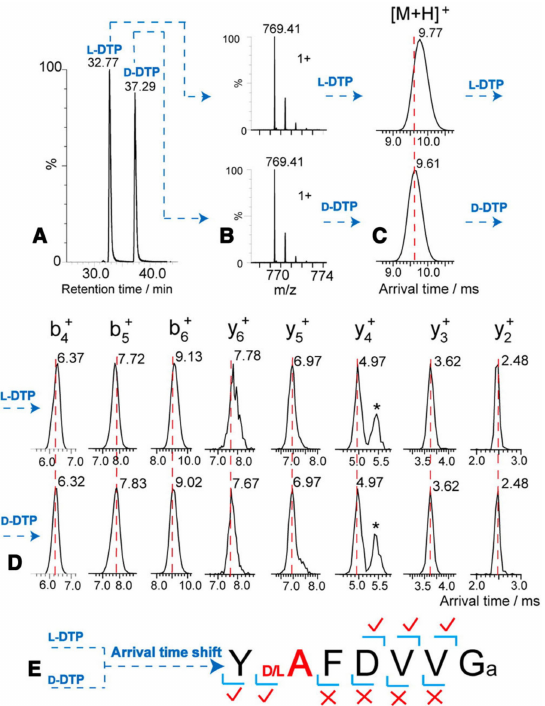
Figure 3. Identification of the epimerization site with LC–MS IMS by comparing the arrival times of the ions of deltorphin having L-Ala (labeled L-DTP) or D-Ala (labeled D-DTP). ( A , B ) LC–MS separation shows similar MS profiles and different retention times, indicating that they are isomeric peptides. ( C ) A shift in arrival time is detected for the L/D-forms. ( D , E ) Following IMS fragmentation, the arrival times of y 2+ , y 3+ , y 4+ and y 5+ are similar in both L-DTP and D-DTP, while the arrival times of the y 6+ ions are different, therefore determining the epimerization site. *, interference ions. Reproduced with permission from